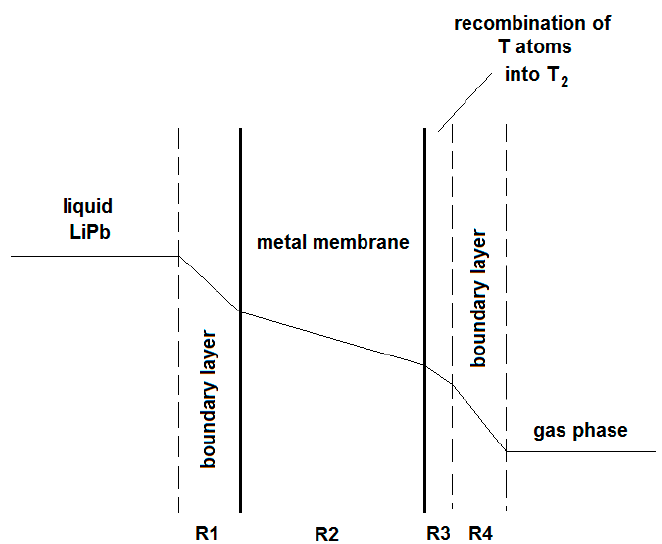
Figure 5. PAV permeator: series of mass-transfer resistance in the extraction of hydrogen isotopes, from liquid LiPb to the gas phase.